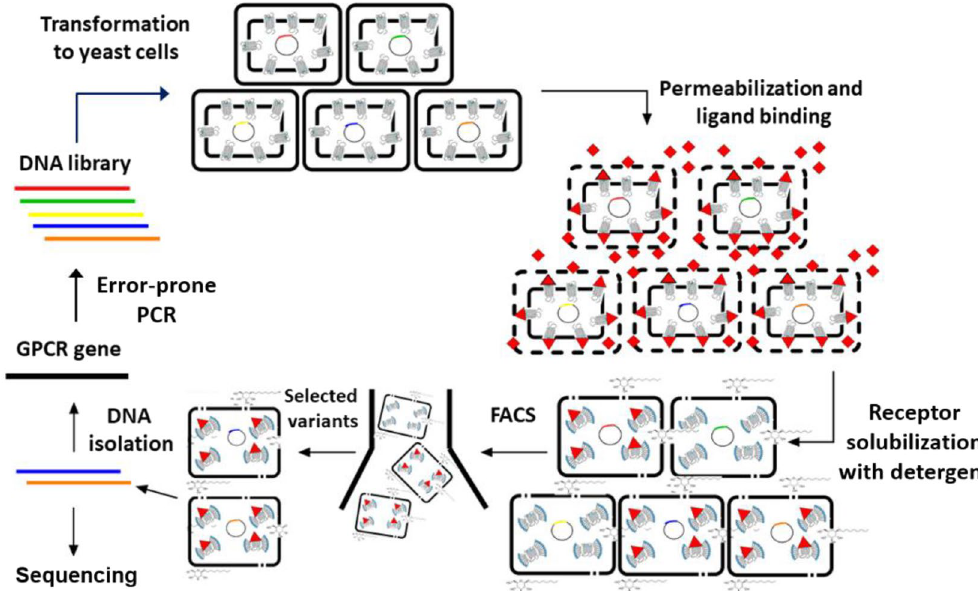
Figure 2. Workflow of YDDS. The evolution of a GPCR starts with a random mutagenesis of the receptor sequence using an error-prone PCR. A yeast library of GPCR variants is then generated by homologous recombination. GPCR-expressing cells are permeabilized and incubated with a fluorescent ligand (in red), followed by the treatment with a short-chain detergent (OG) to solubilize the plasma membrane and receptor. Subsequently, cells, which express receptor variants stable in the presence of OG are isolated by FACS and genotyped.